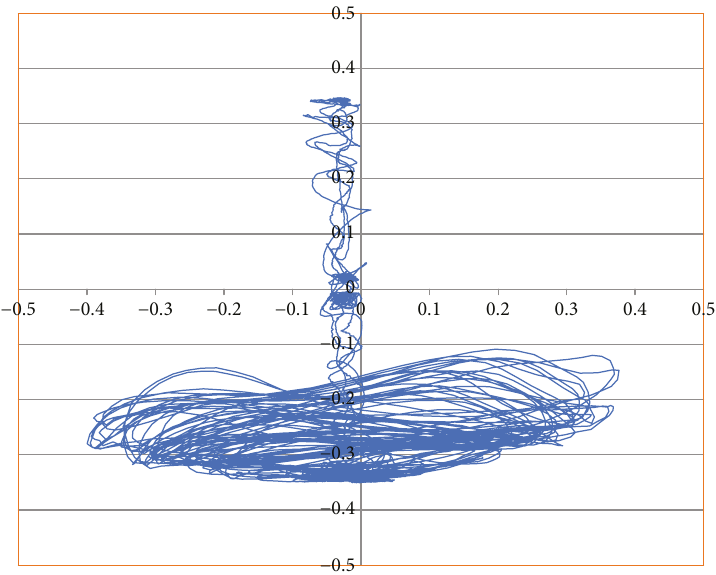
Figure 13: Locus of the CoM in the Z-Y plane (blue line) compared with tank internal envelope (orange